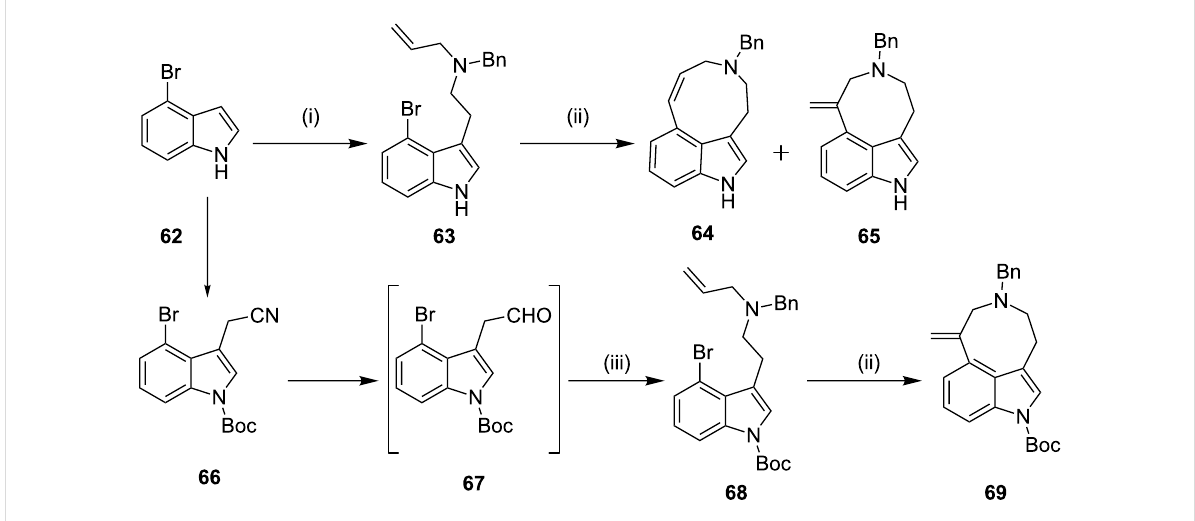
Scheme 10: Synthesis of seco -C/D ring analogs of ergot alkaloids through intramolecular Heck reaction. Reagents and conditions: (i) (a) POCl 3 , DMF, 0–40 °C, 1 h, 78%; (b) MeNO 2 , cat. NH 4 OAc, reflux, 3 h, 80%; (c) LiAlH 4 , THF, reflux, 4 h, 88%; (d) PhCHO, NaBH(OAc) 3 , CH 2 Cl 2 /THF, rt, 46%; (e) allyl bromide, MeCN, rt, 24 h, 69–72%; (ii) 25 mol % Pd(OAc) 2 , 55 mol % P( o -Tol) 3 , NEt 3 , MeCN, reflux, 12 h; (iii) DIBAL-H, 0 °C, 15 min, rt, 2 h, CH